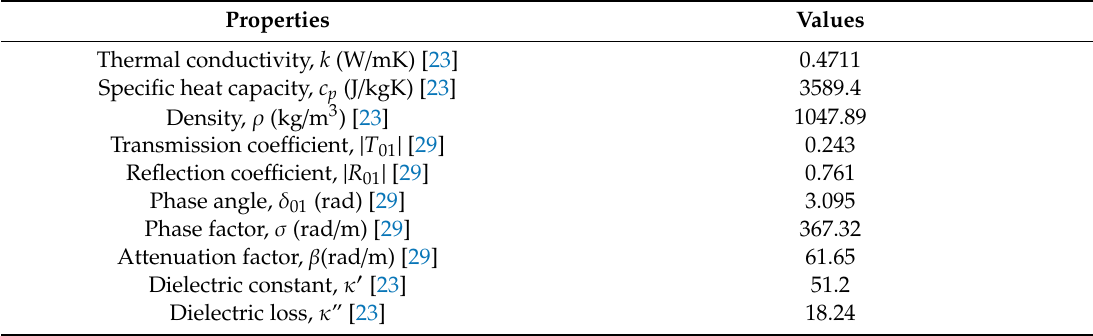
Table 2. Thermal and dielectric properties of salmon fillets ( f = 2450 MHz). Properties